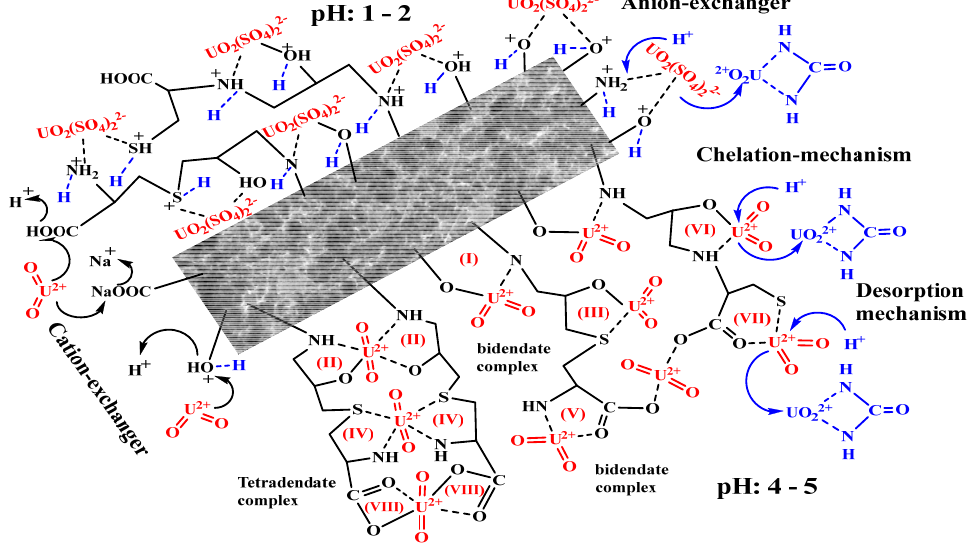
Table 6. Metal desorption and sorbent recycling.